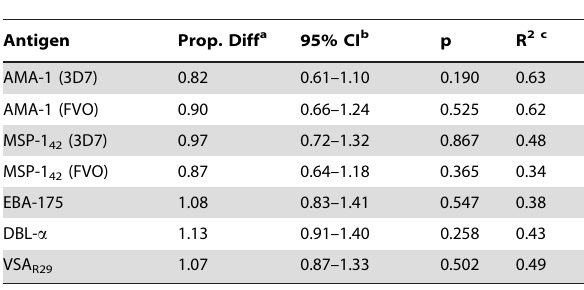
Table 1. Multivariate linear regression model showing the effect of RTS,S vaccination on levels of IgG to blood stage antigens, compared to control vaccination, adjusted by cohort, age, IFAT titer at baseline, batch of experiments, previous episodes and present